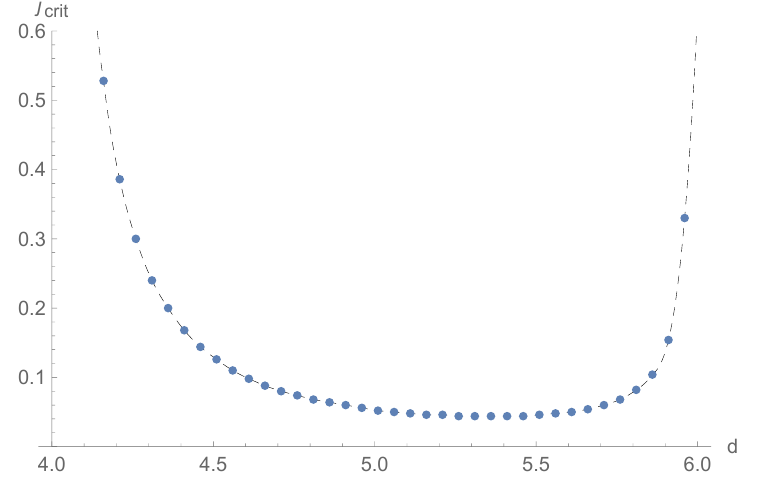
Figure 4 . Numerical estimate of the critical value of ˆ j as a function of d , for 4 < d < 6 . The dashed line is a smooth interpolation of the numerical